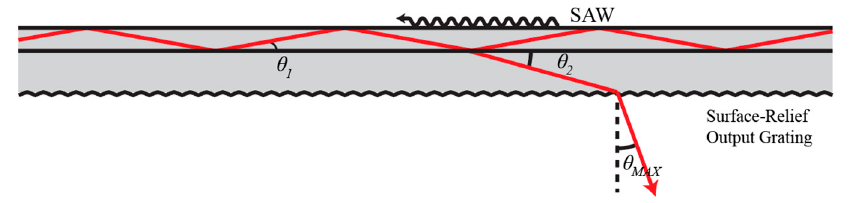
Figure 2. The original design for a face-exiting flat-screen near-eye display.